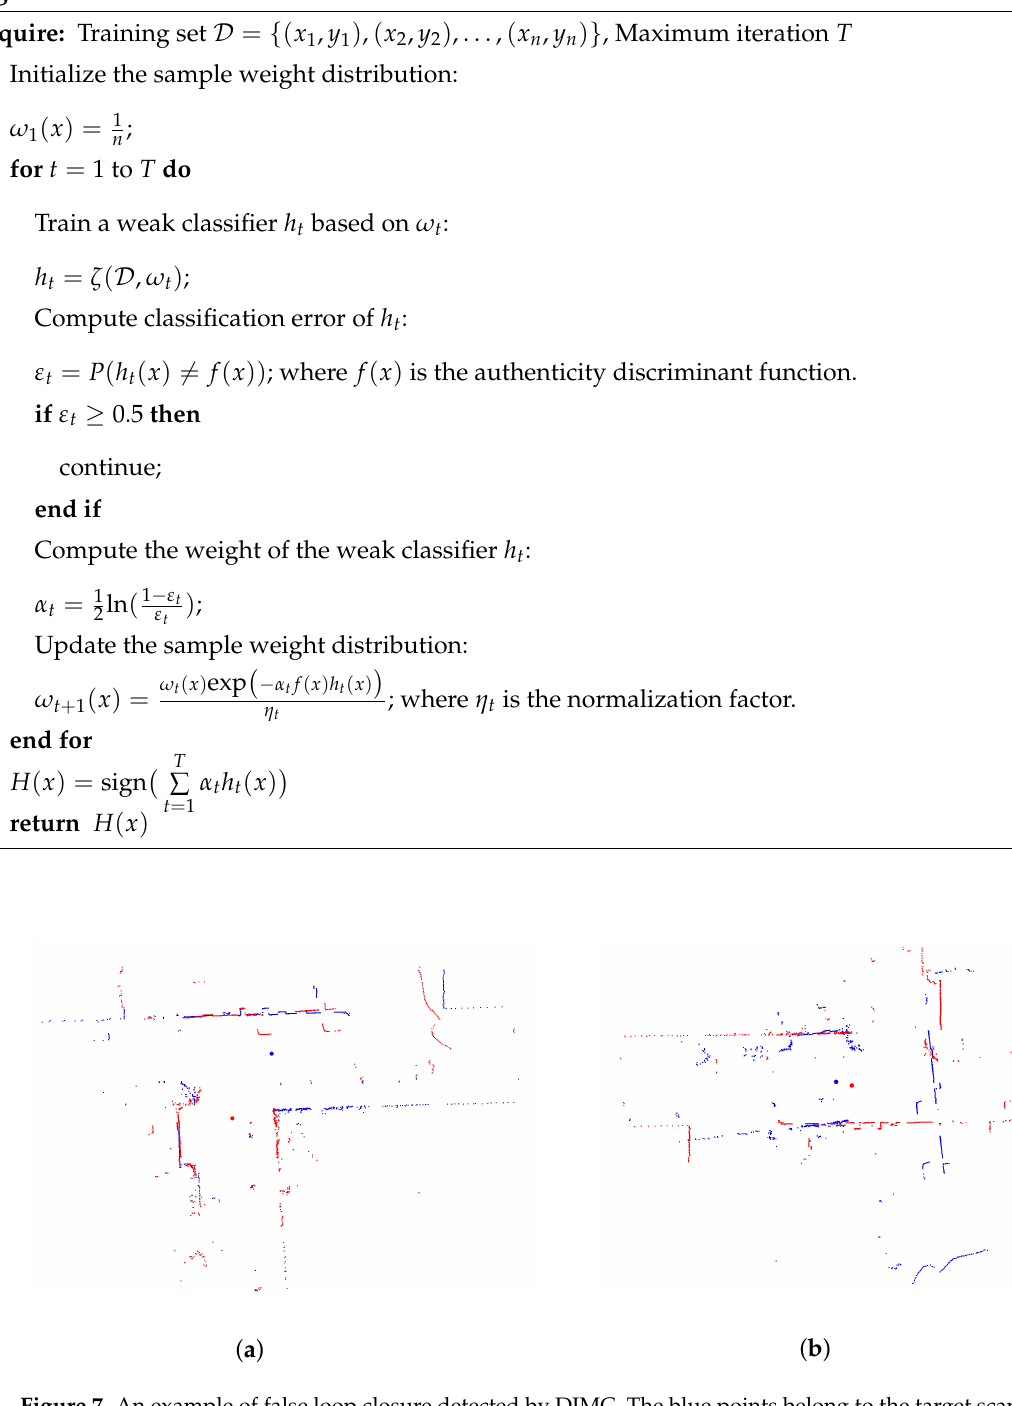
Algorithm 3 Classifier based on AdaBoost